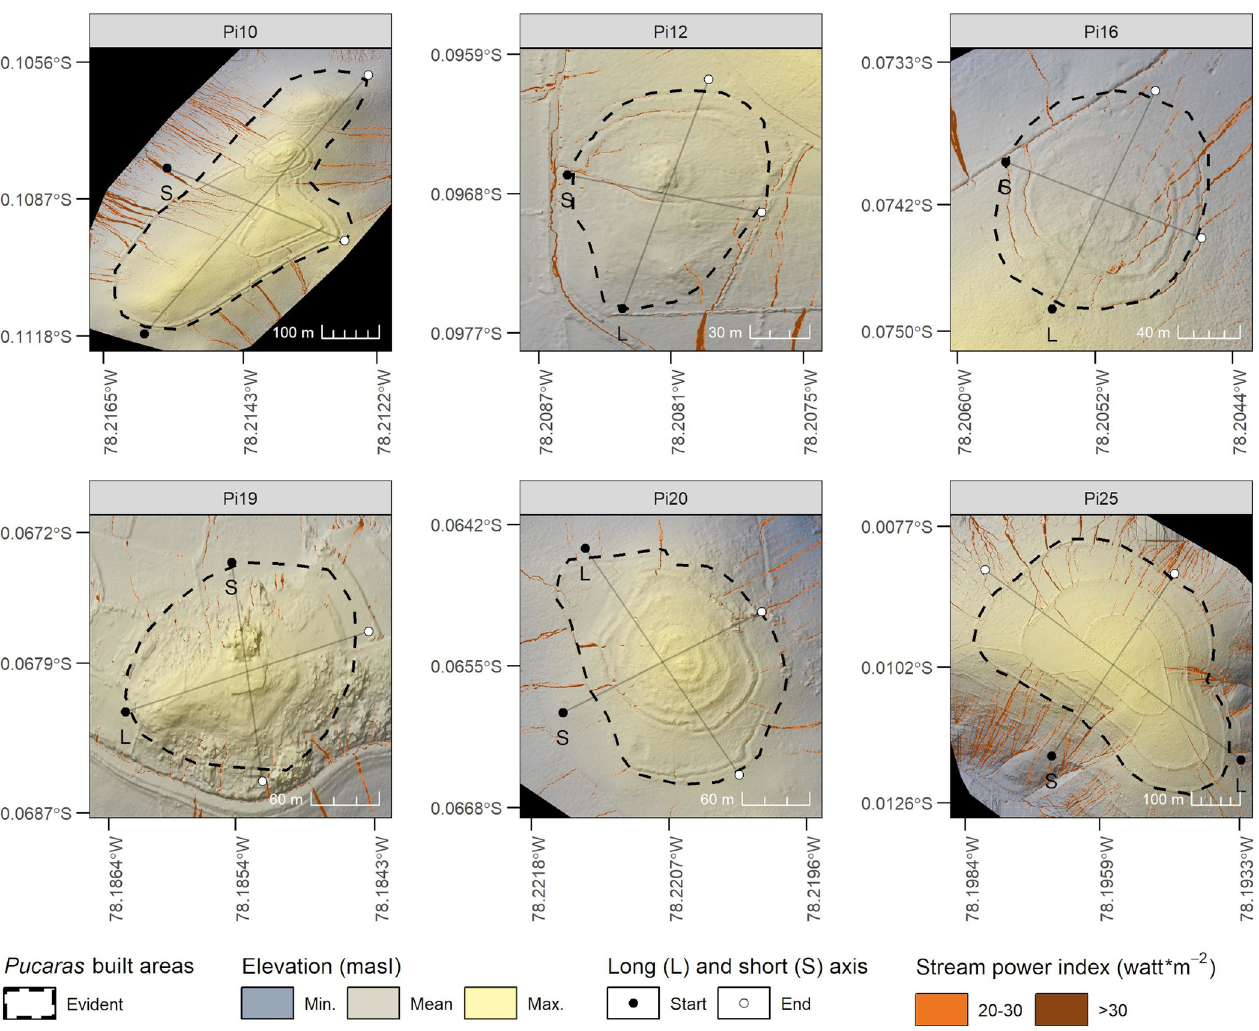
Fig 7. High spatial resolution DTMs, gully-erosion-prone areas and axes for the evident built area of Pucaras